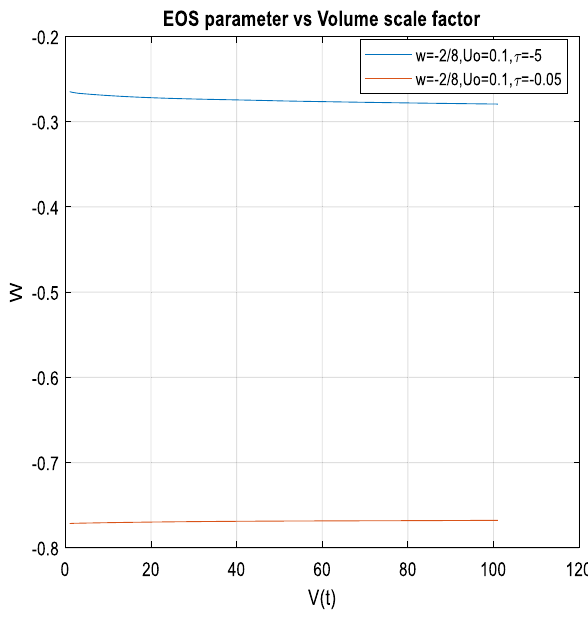
, U = 0 . 1 and τ = 0 8